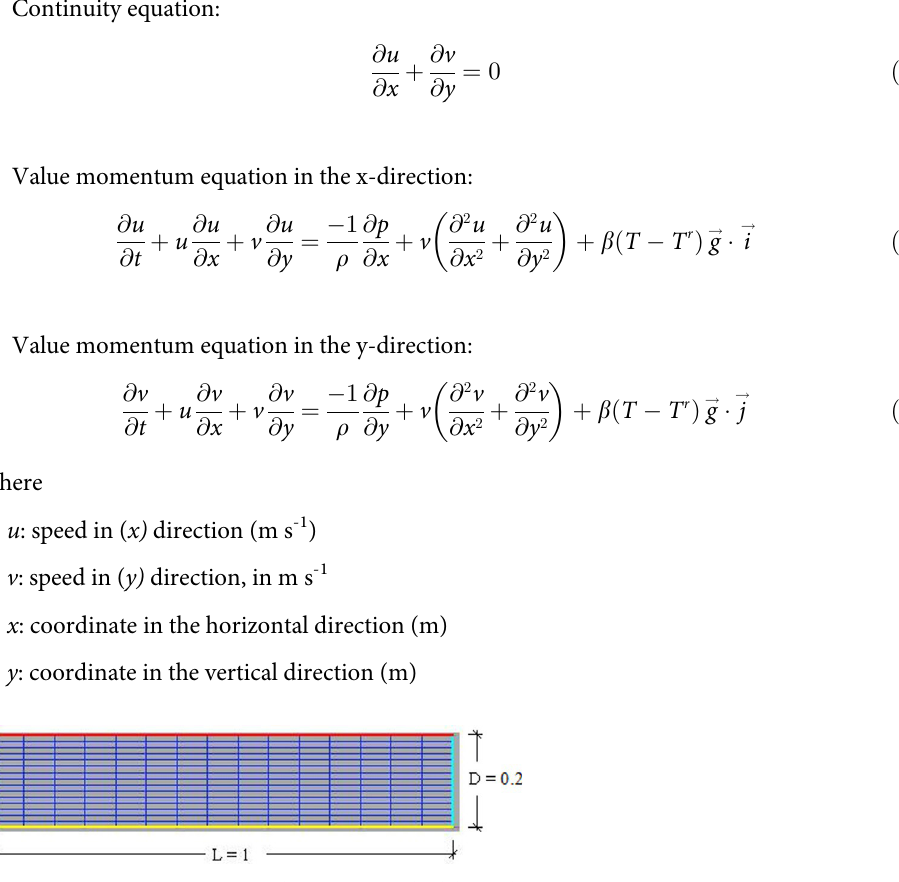
Fig 4. Symmetric and computational geometric mesh of the gas heat